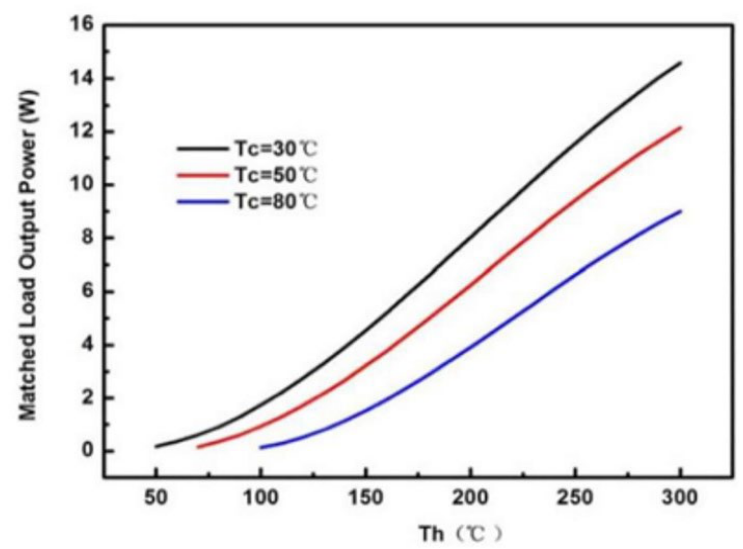
Figure 2. Power data of TEG module.